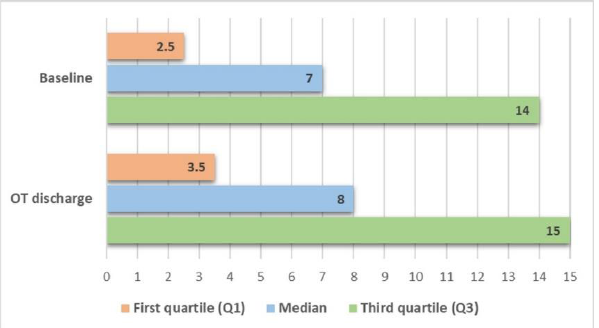
Figure 2. Daily mobility, before and after the occupational therapy (OT) program ( n = 17).